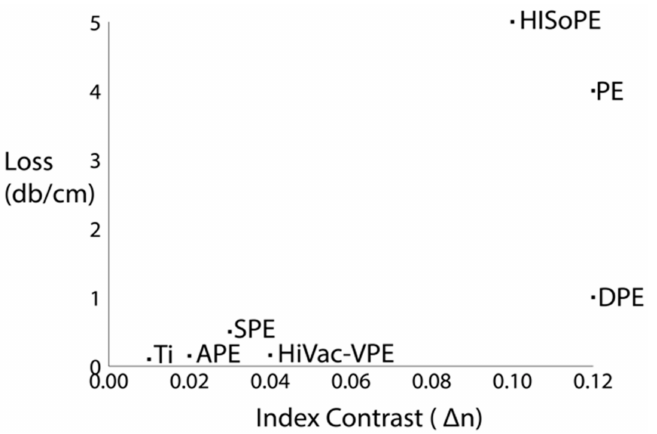
Figure 8. Visualization of extraordinary index contrast vs. loss for selected proton exchange tech- niques